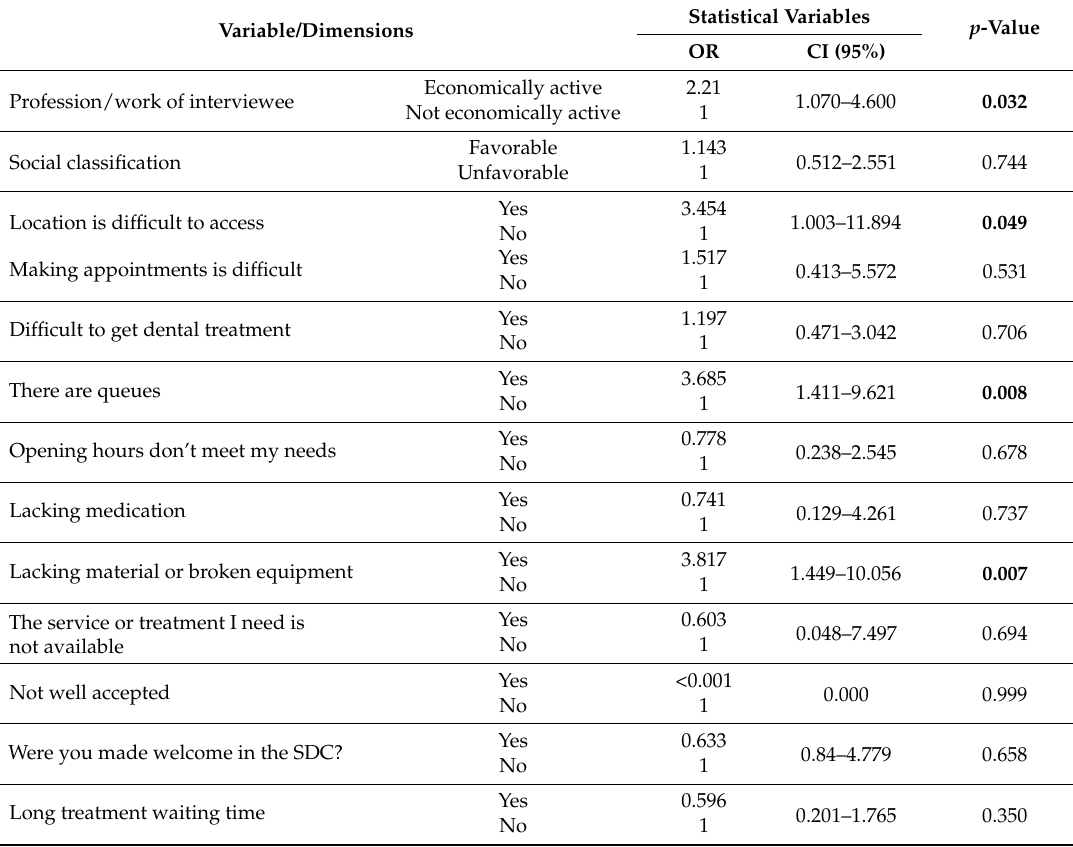
Table 5. Binary logistic regression analysis of users’ unfavorable perceptions in relation to the resolutive nature of oral health services and sociodemographic and service-related variables ( n =